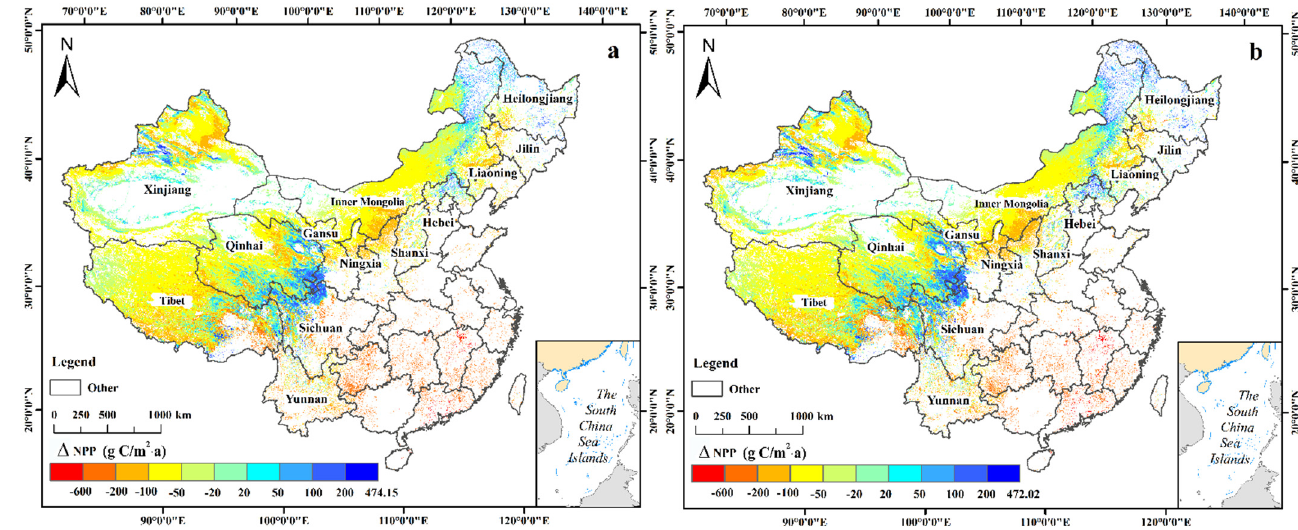
Figure 7. The spatial characteristics of the NPP changes caused by human activities before (2004–2010) (left: ( a )) and after (2011–2017) (right: ( b )) the implementation of the SISGC policy. After the SISGC, the positive influence of human activities on all grassland super-class groups was enhanced, with an increase ranging from 0.28 g C m − 2 a − 1 to 18.29 g C m − 2 a − 1 (Table 3). Among them, the increased area of positive influence in the Temperate humid grassland was the most prevalent, increasing by 6.71%. The increased area of negative influence in the Tropical forest grassland was the lowest, recorded as 0.30% (Table 3). Table 3. The NPP changes (g C m − 2 a − 1 ) caused by human activities before (2004–2010) and after (2011–2017) the implementation of the